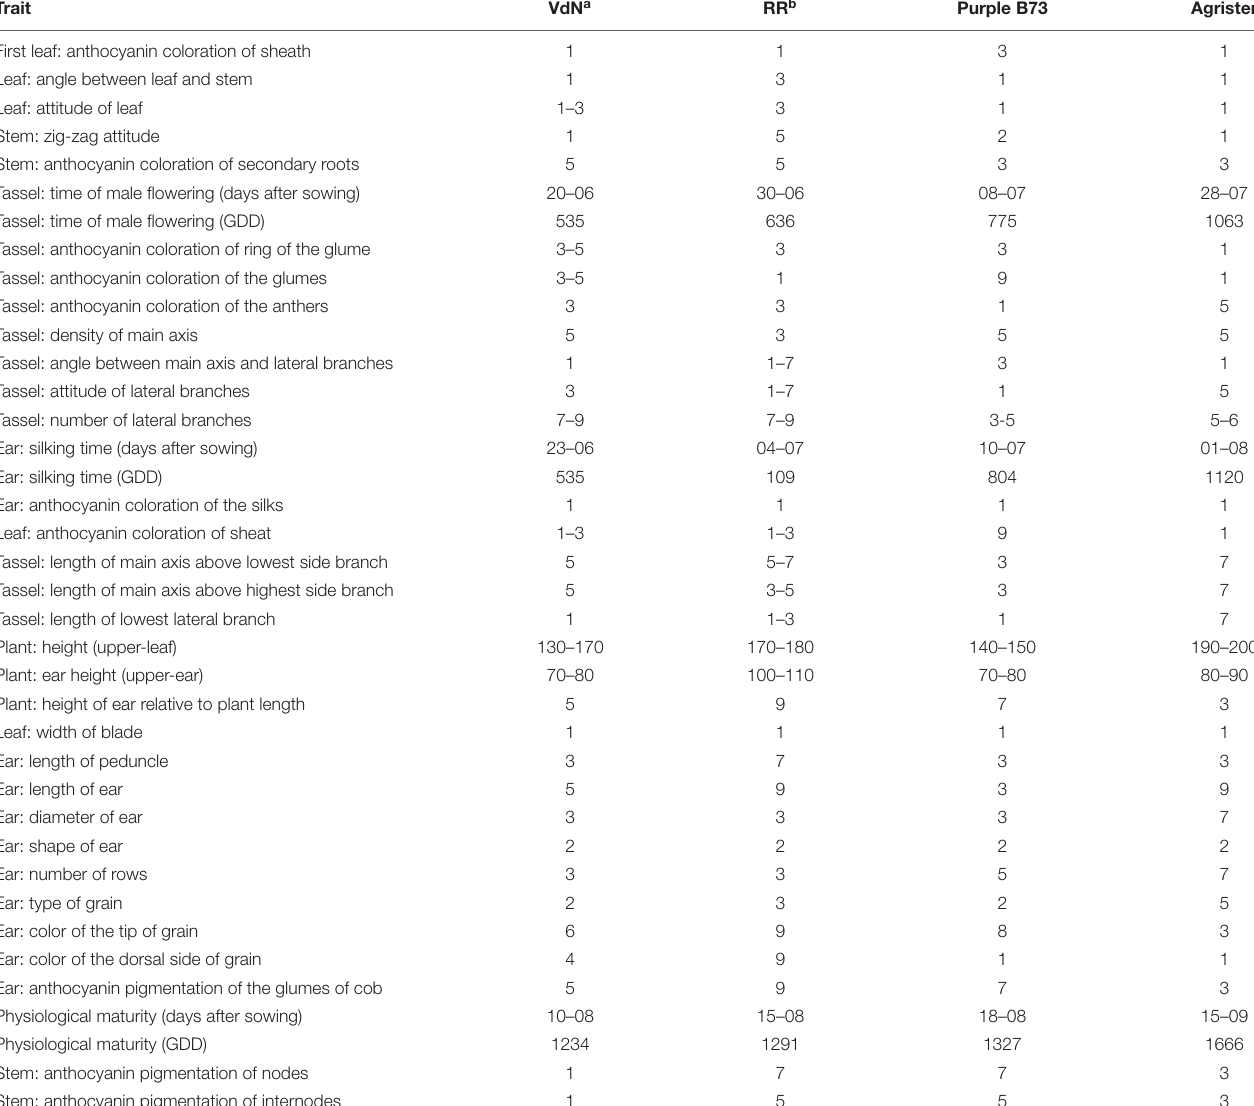
TABLE 2 | Morphological and physiological traits of all the genotypes according to the UPOV characters. Trait VdN a RR b Purple B73